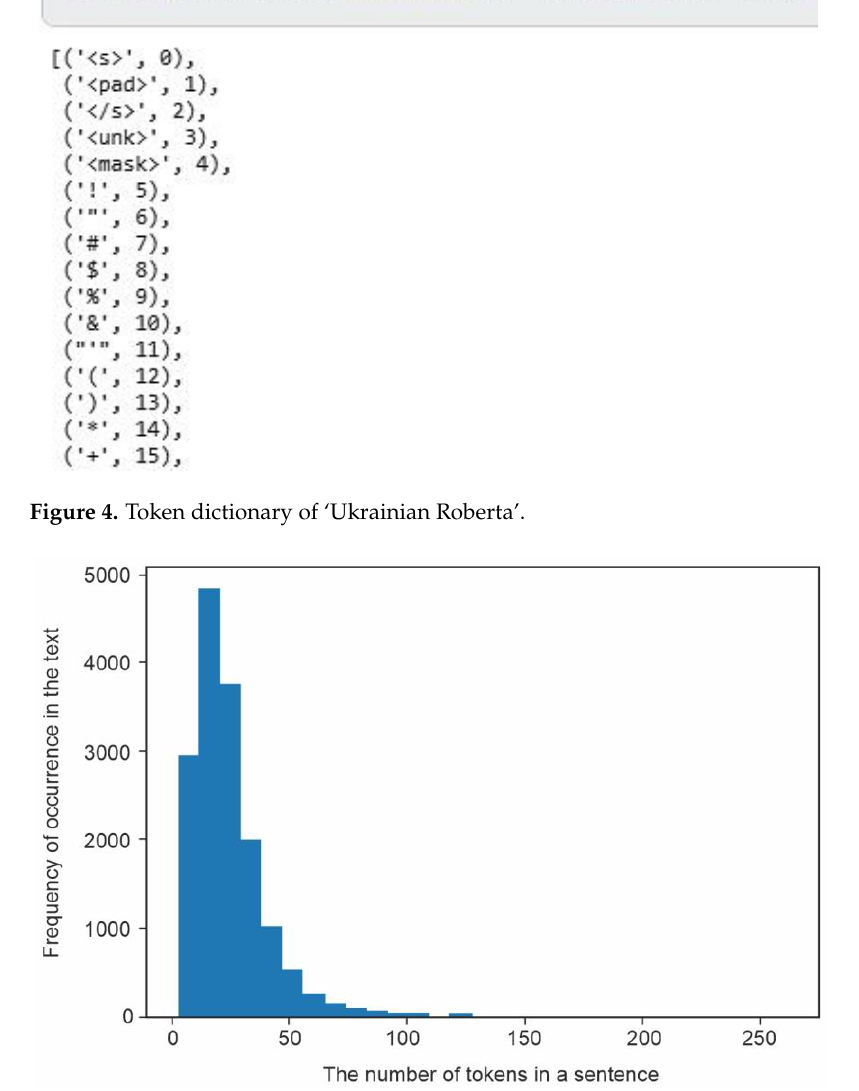
Figure 5. Distribution of the number of tokens in the training sample.